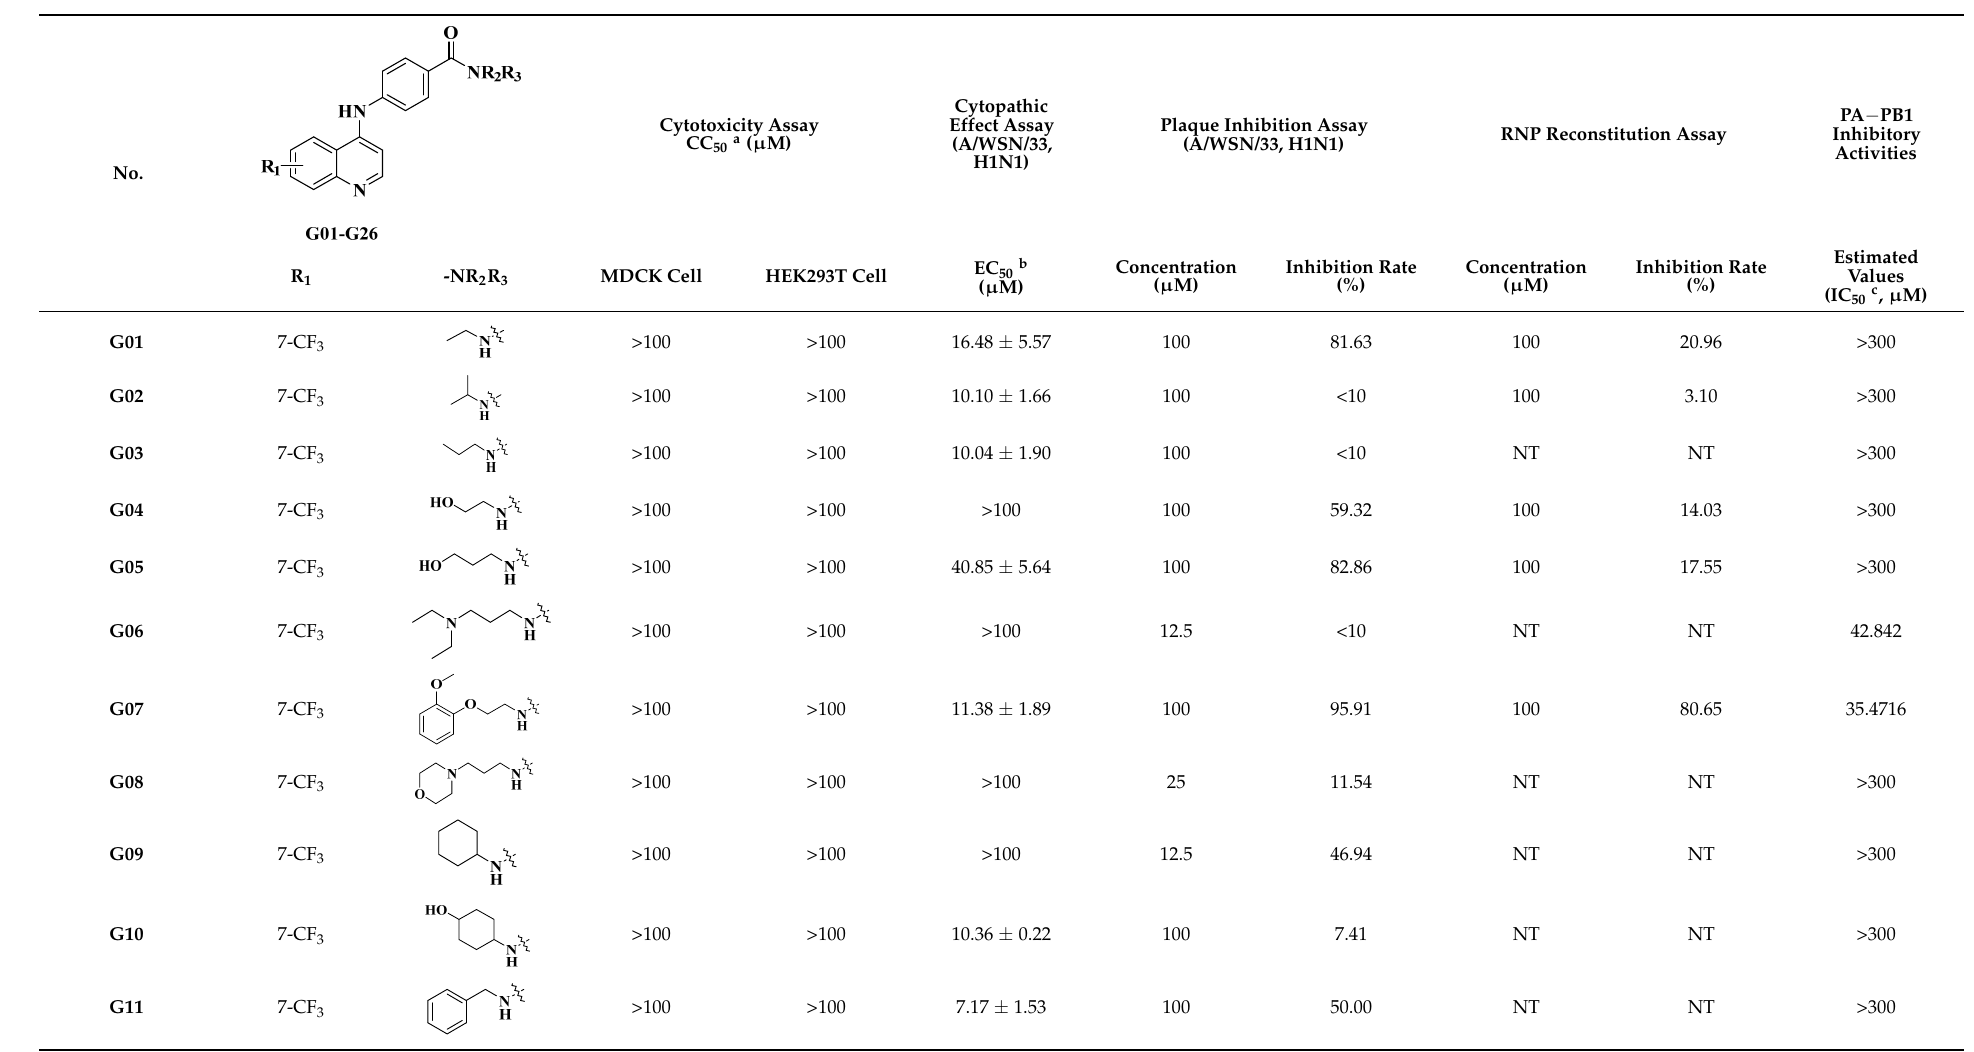
Table 1. The results of compounds G01 – G26 in cytotoxicity assay, cytopathic effect assay, plaque inhibition assay and PA–PB1 inhibitory activity